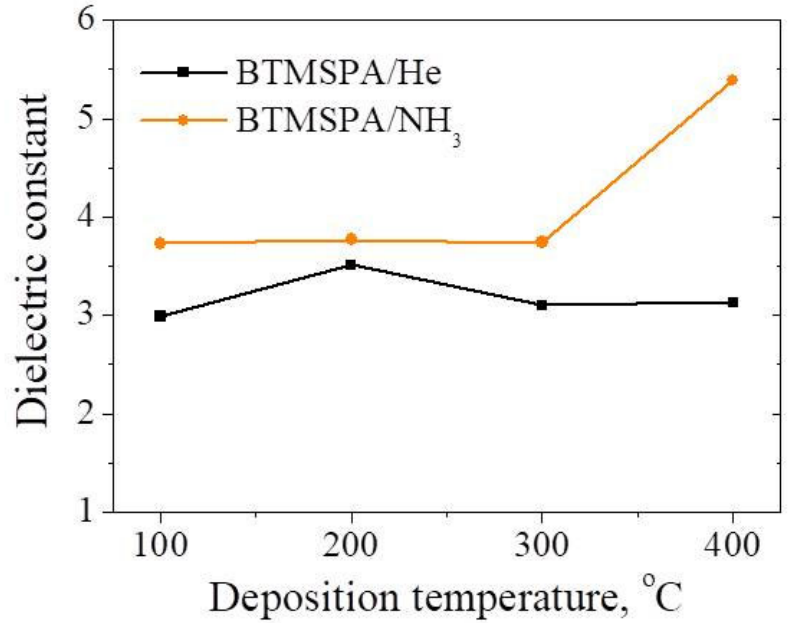
Figure 9. Temperature dependences of dielectric constant of SiCN films deposited using BTMSPA/He and BTMSPA/NH 3 mixtures.